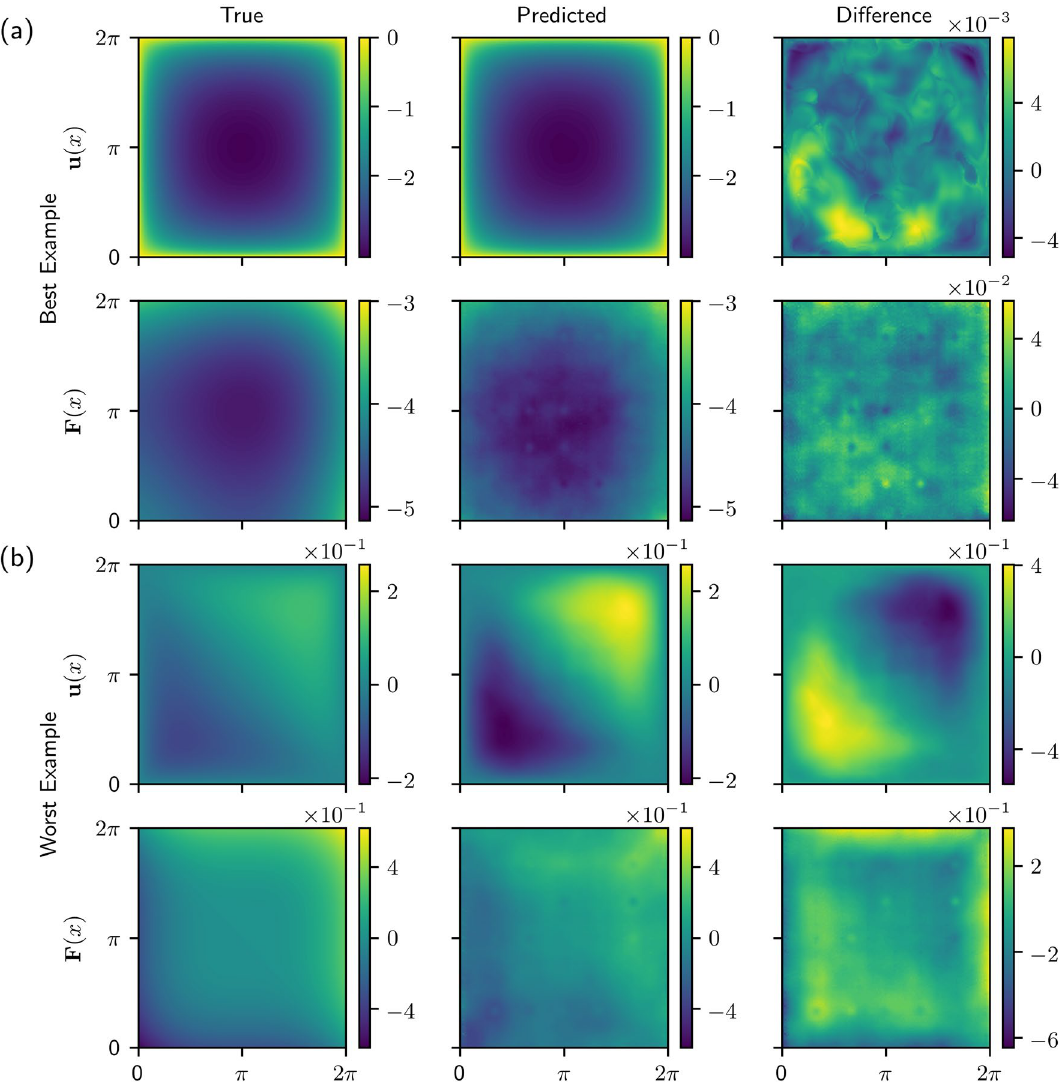
the true solution or forcing function ( Difference = ( True − Predicted )/ || True || ∞